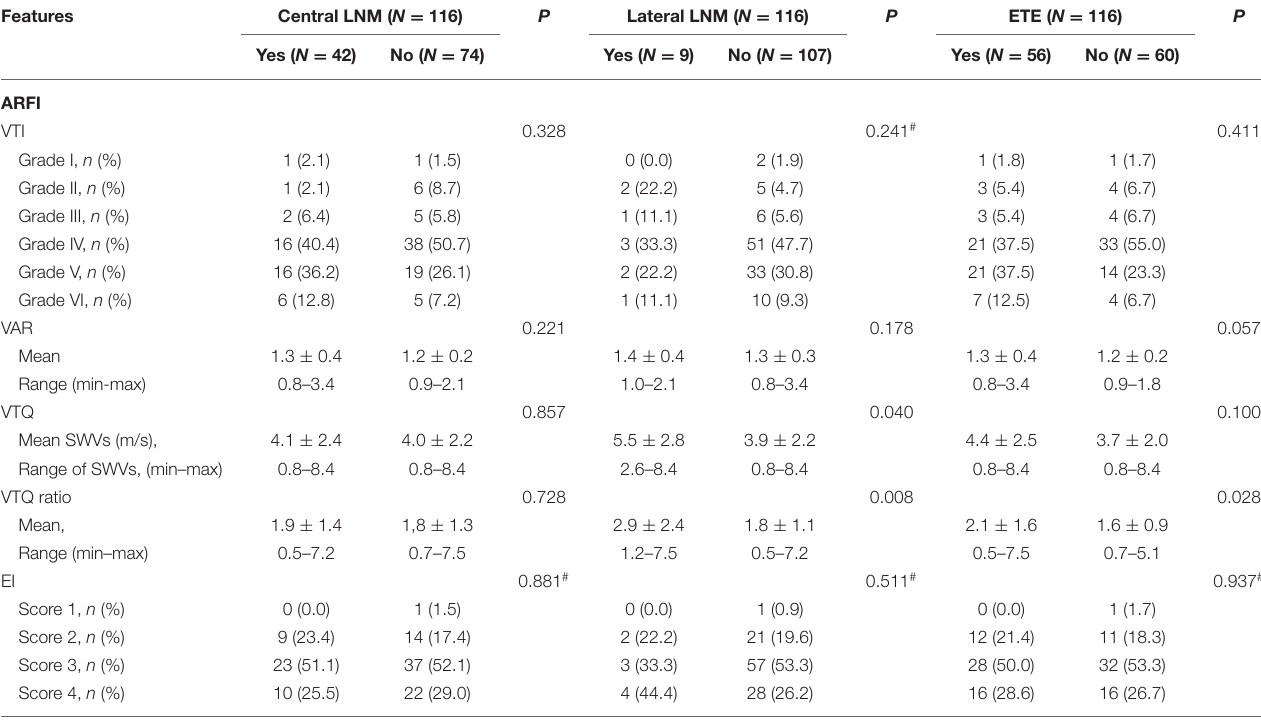
TABLE 3 | The EI and ARFI imaging features of the papillary thyroid cancer. Features